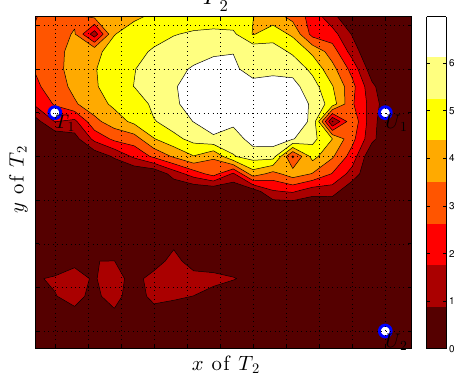
Figure 3: Transmission power P (2) phase for the CR scheme depending on the location of T 2